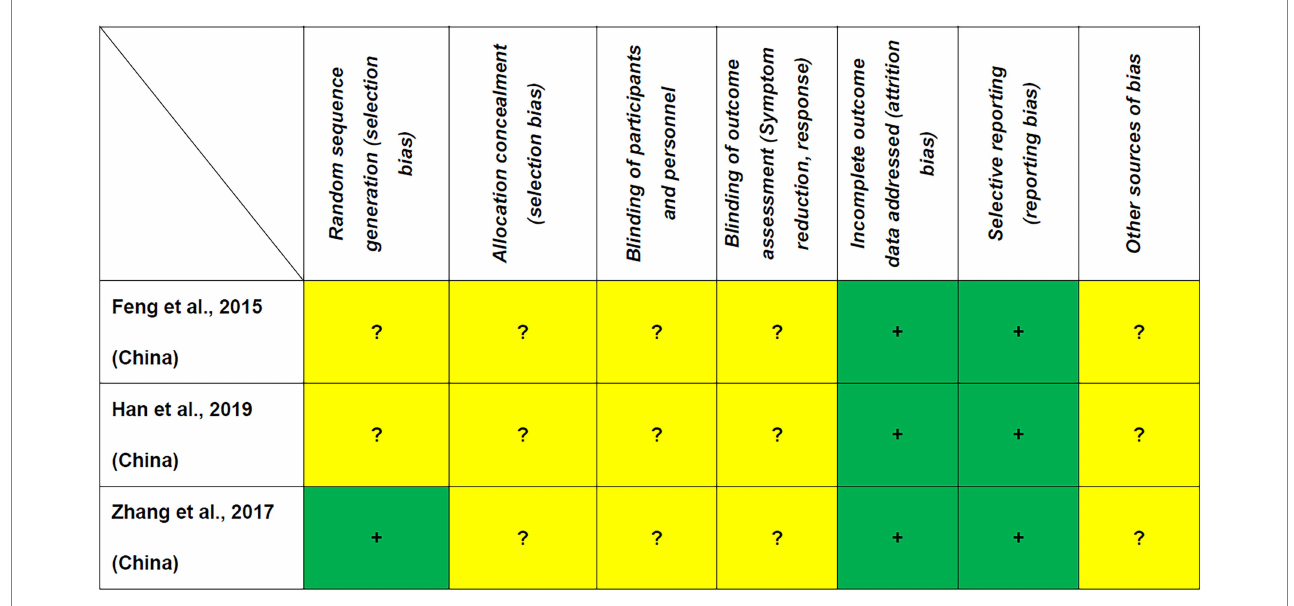
Sham stimulation Findings group group